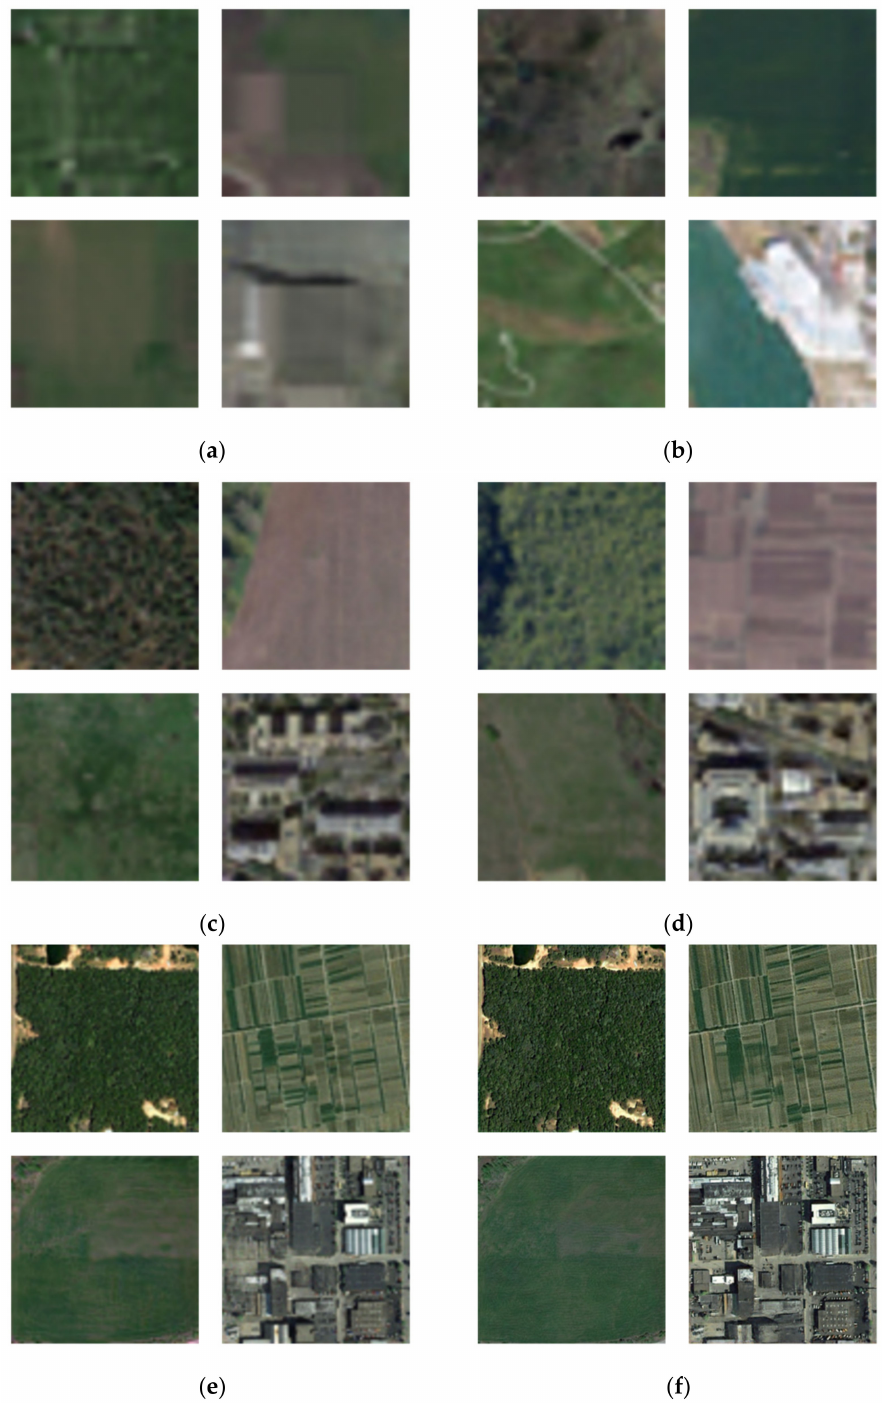
Figure 11. Comparisons of pseudosamples generated by different methods. ( a ) Deep Convolutional GAN (DCGAN), ( b ) Wasserstein GAN (WGAN), ( c ) Multiple-layer Feature-matching GAN (MARTA GAN), ( d ) Attention GAN, ( f ) SinGAN, ( e ) Improved